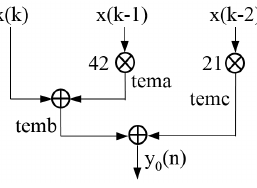
Figure 3. The first channel structure.